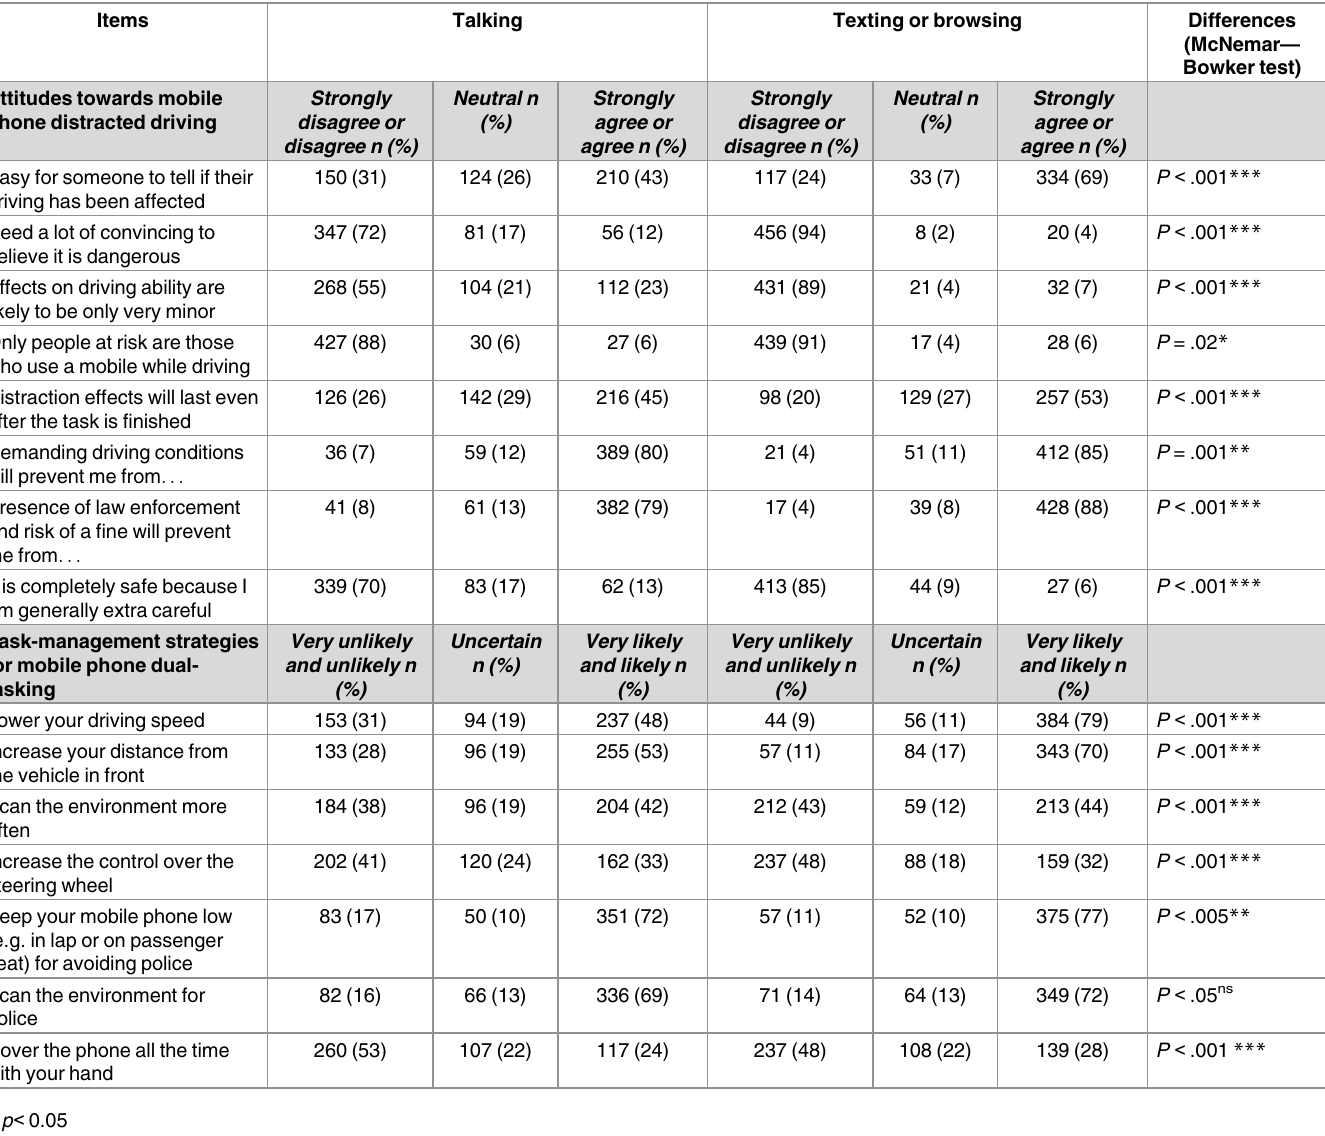
Table 4. Self-reported attitudes and task-management strategies for mobile phone distracted